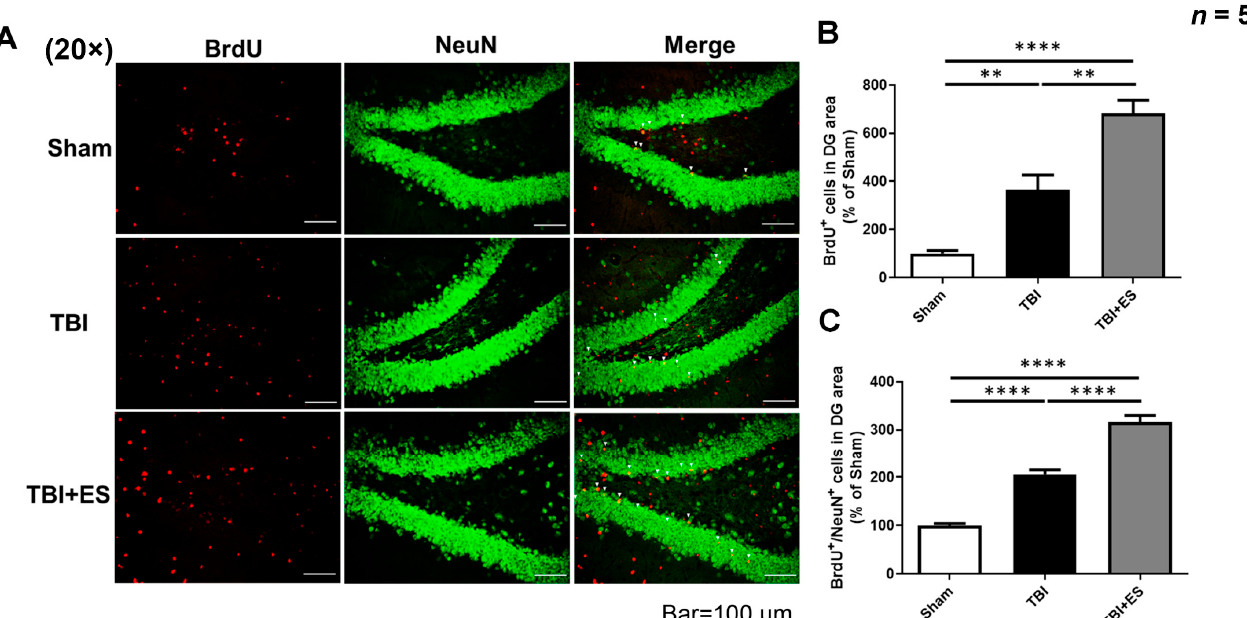
Figure 6. CES stimulates the proliferation of cells and increases the number of mature newborn neurons in the dentate gyrus of the hippocampus. ( A ) Representative fluorescence images of NeuN (green), BrdU (red), and merged picture. ( B ) Quantitative analysis showed significantly increased BrdU immunoreactive cells in the dentate gyrus. ( C ) Quantitative analysis demonstrated that BrdU/NeuN co-stained cells, indicating mature newborn neurons, are significantly increased in the TBI + ES group. Values are expressed as the mean ± SEM. **** p < 0.0001, ** p < 0.005.